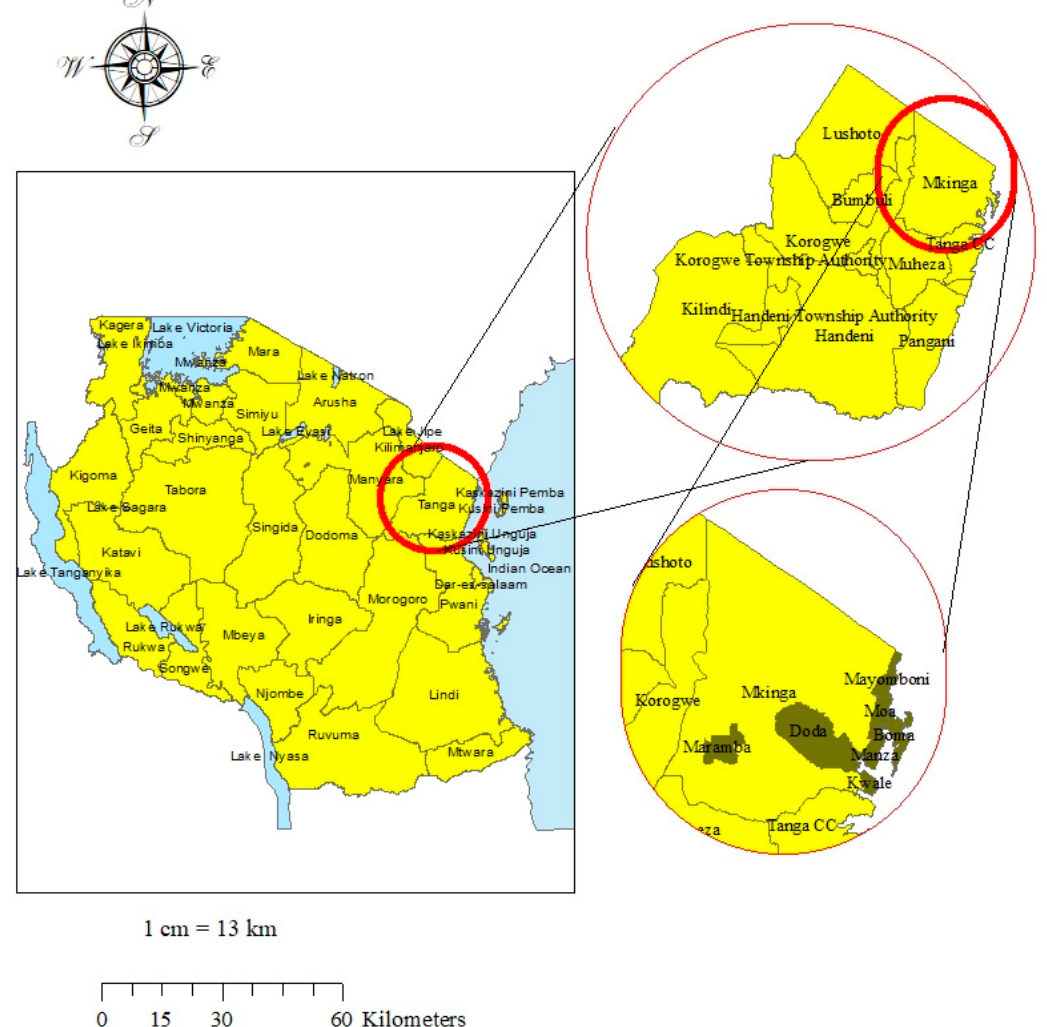
Figure 1. Map of the study site. Left is the map of Tanzania located in the Eastern part of Africa. The top-right figure shows the map of Tanga region, where the Mkinga district is located. The bottom- right figure shows the map of wards in the Mkinga district, whereby villages in these wards